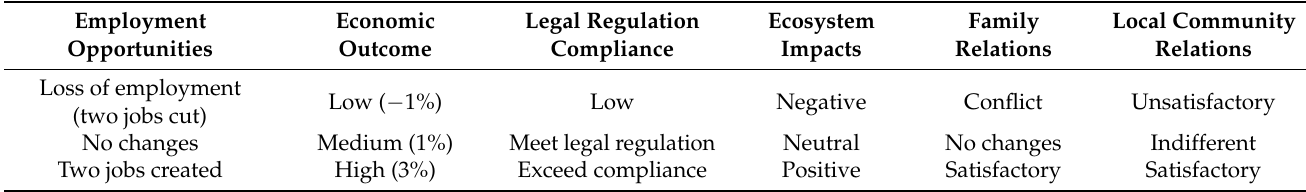
Table 1. Variables and levels of the